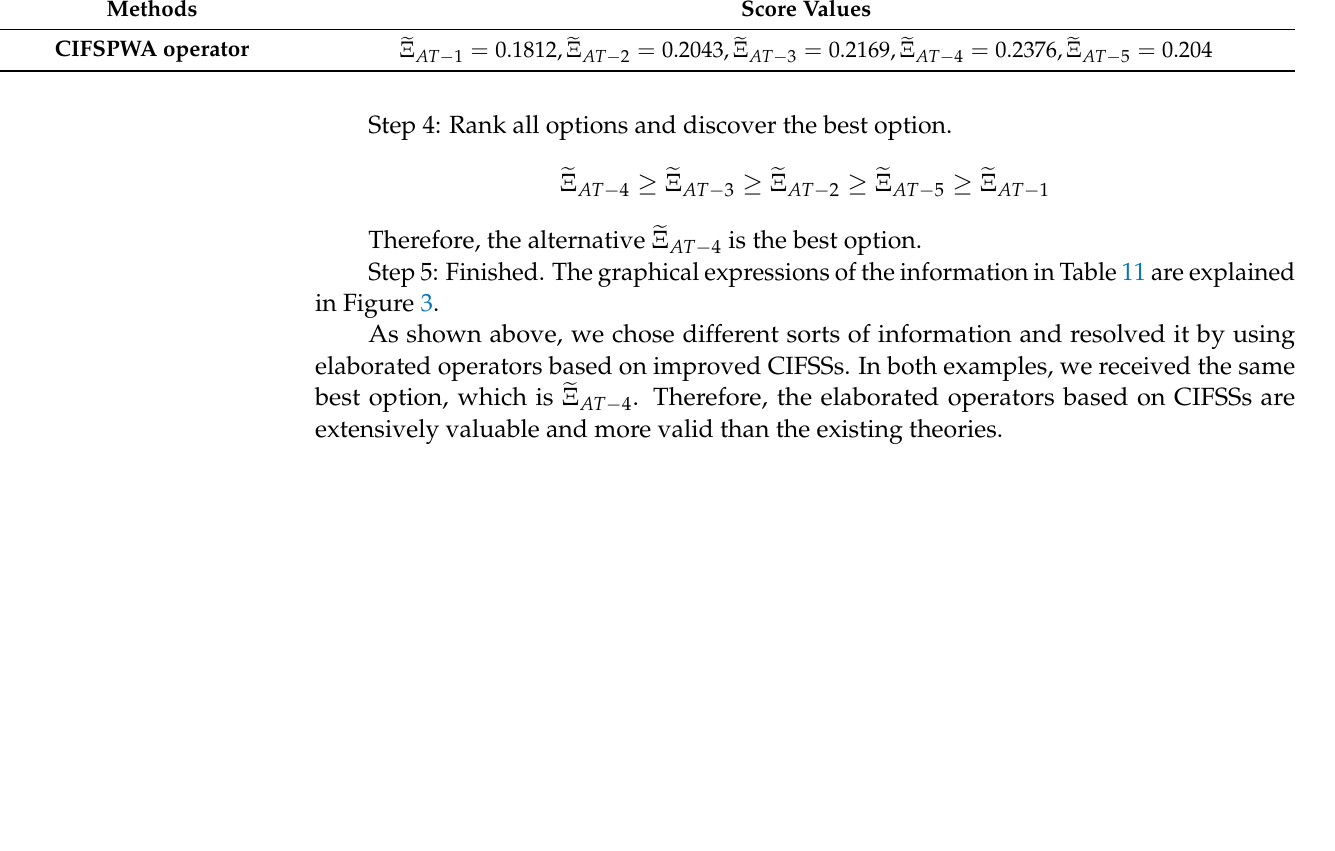
Table 11. By using the information in step 2, we obtain the score values. Methods Score